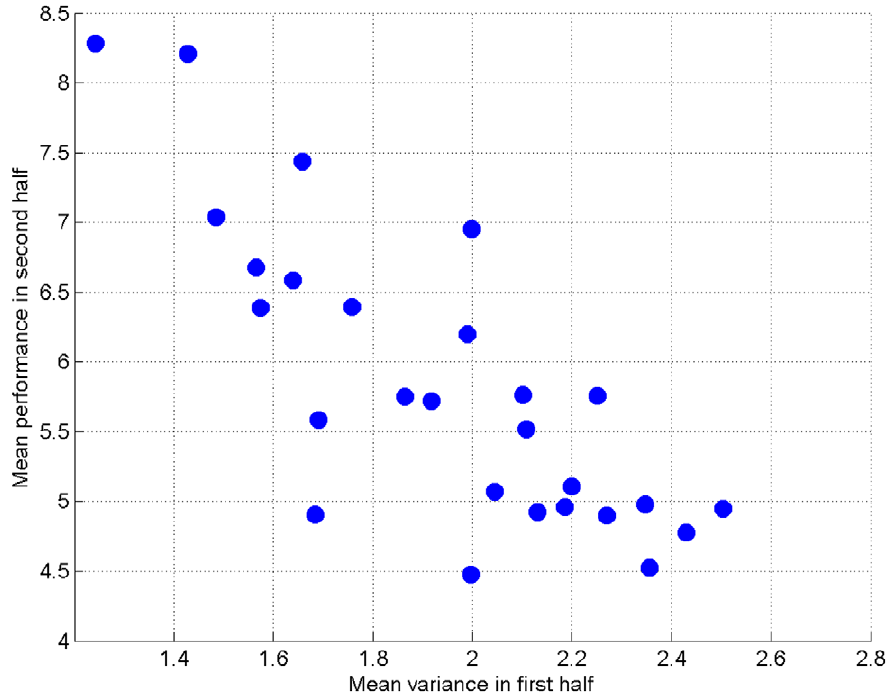
Figure 7. Greater exploration associated with improved performance, across different participants.